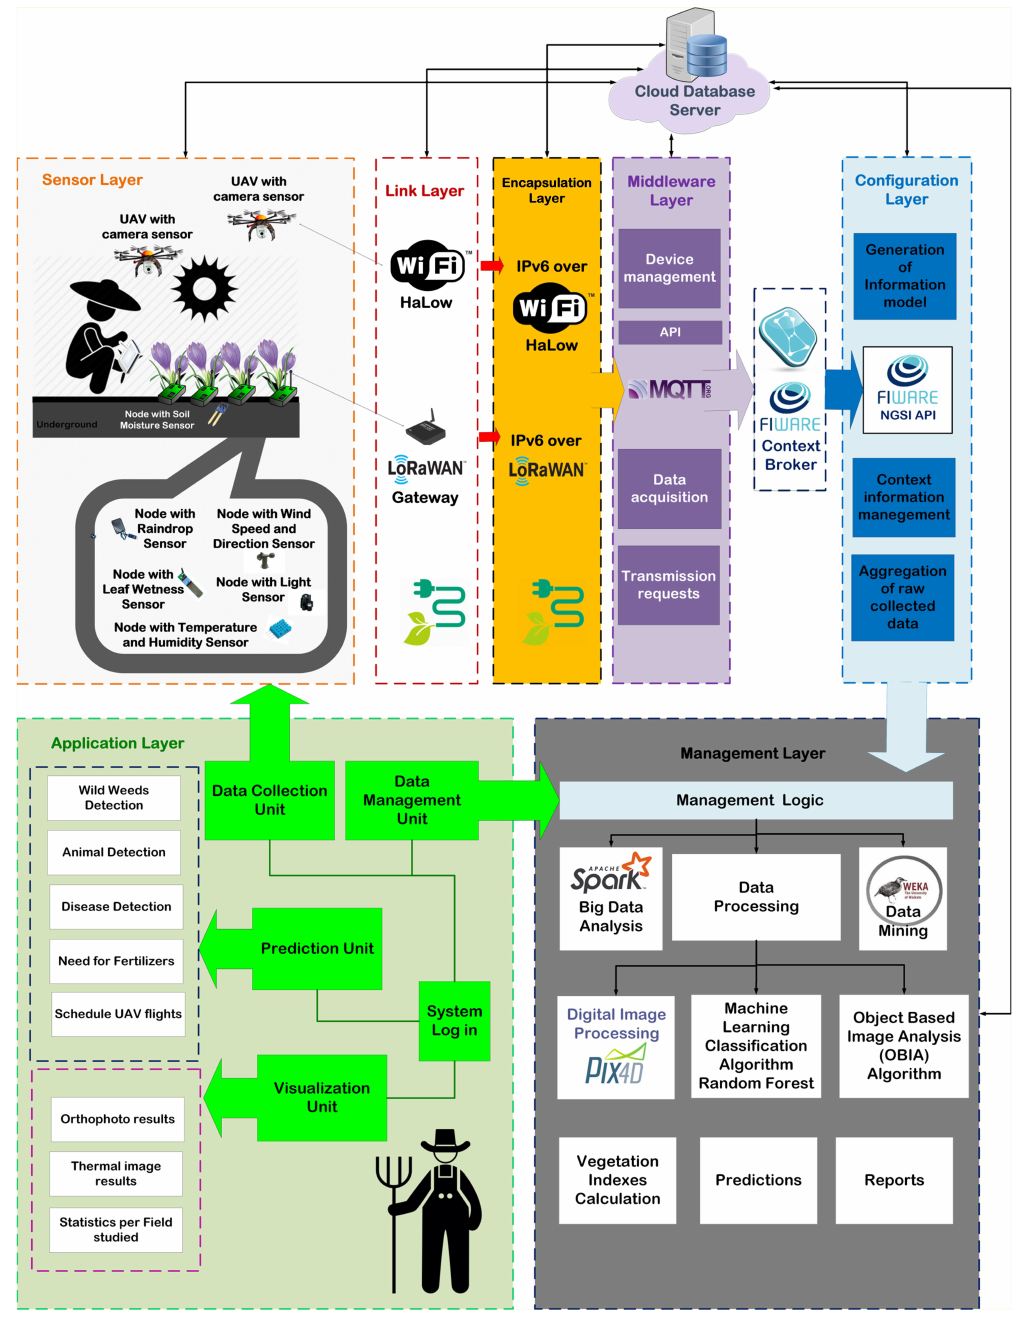
Figure 4. The DIAS